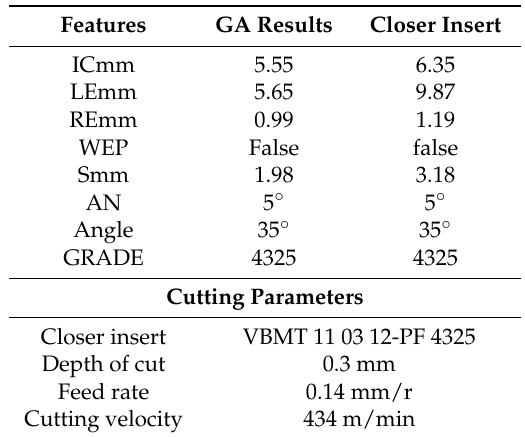
Table 16. Results of the finishing operation